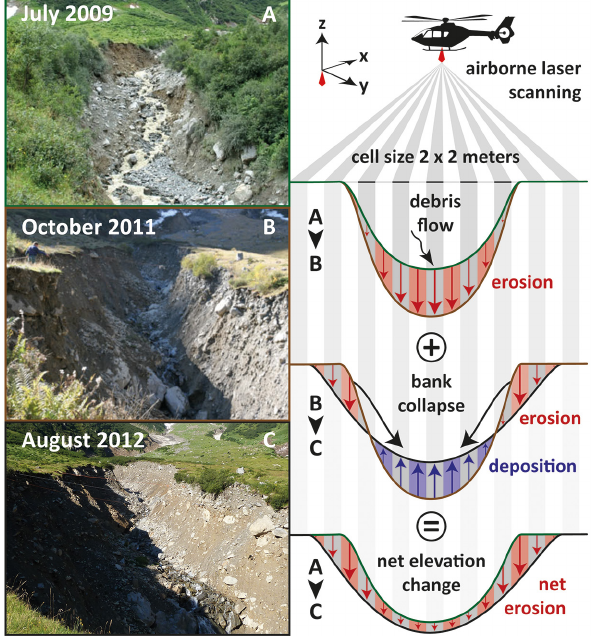
Figure 8. Conceptual model for the evolution of the debris-flow channel, in three stages, at the Spreitgraben during the three active years after the re-activation of the channel following the first large debris flow July 2009 (photos taken by Geotest in 2009 and 2011, by Florian Frank in 2012). Several reiterations showing primary ero- sion ( a to b ) by debris flow degradation and secondary erosion ( b to c ) composed of lateral bank collapses result in channel degra- dation and widening, while the channel bed is often composed of fresh and easily erodible sediment deposits. Shaded columns are in- dicating observed erosion and deposition volume per cell. Arrows represent the mean erosion and deposition